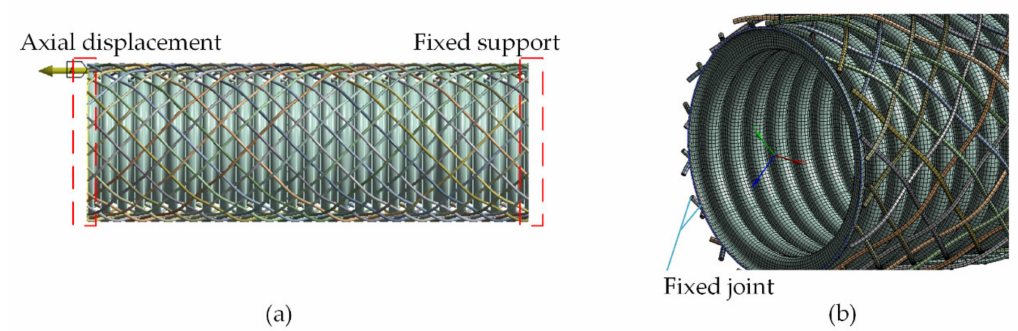
Figure 9. Finite Element Model of the DN25 braided corrugated hose: ( a ) Boundary condition, ( b ) Fixed joint.